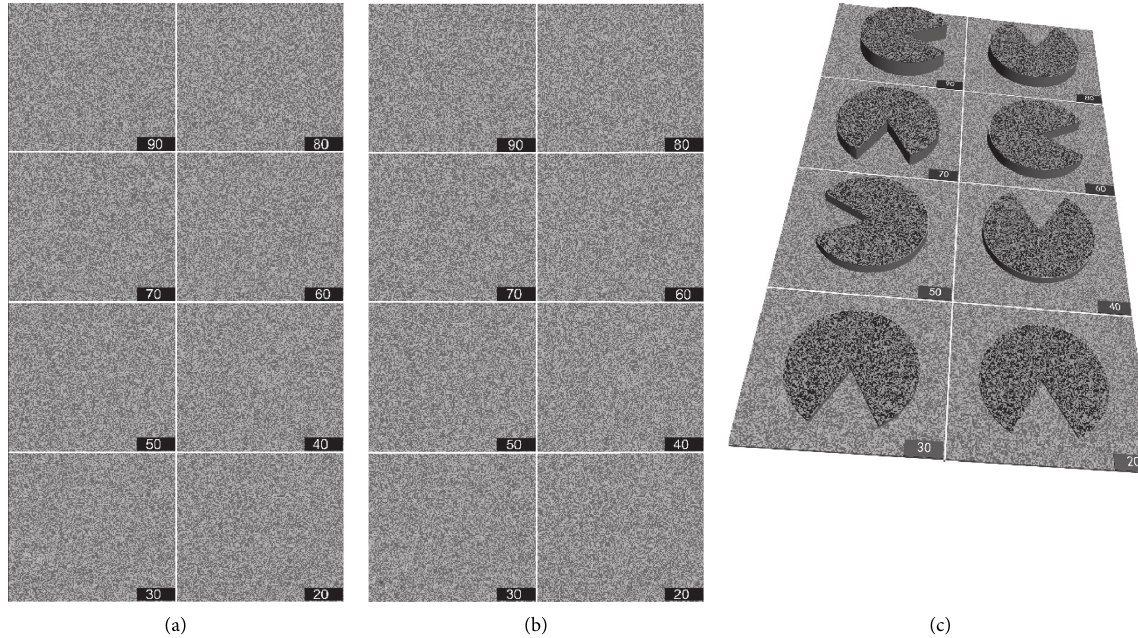
Figure 3: Legend of random-dot-based pattern of the first page of the second-grade test page with 50% contrast for a maximum brightness of 120 lux. (a) Picture viewed by the left eye. (b) Picture viewed by the right eye. (c) Simulation of the perception generated by the test images. The luminance of the dark and light elements was 40 lux (grayscale no. 43, RGB [110, 110, 110]) and 120 lux (grayscale no. 71, RGB [181, 181, 181]), respectively. The setting disparity of the mouth of the Pacman was 90 ″ (facing right), 80 ″ (facing up), 70 ″ (facing down), 60 ″ (facing right), 50 ″ (facing left), 40 ″ (facing up), 30 ″ (facing down), and 20 ″ (facing down). If the stereopsis of a subject is better than the setting disparity, the mouth of the Pacman should be distinguished when fusing